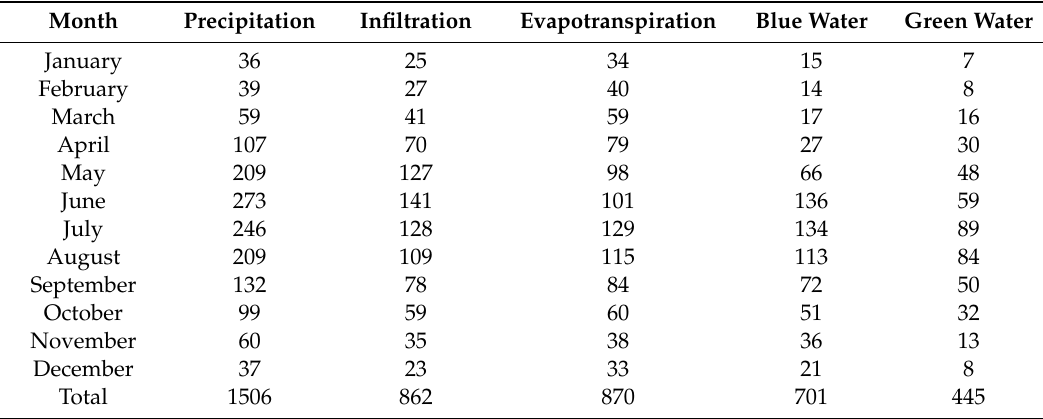
Table 9. Annual average of water cycle fluxes during the prediction period and their change rates compared to the base period results.